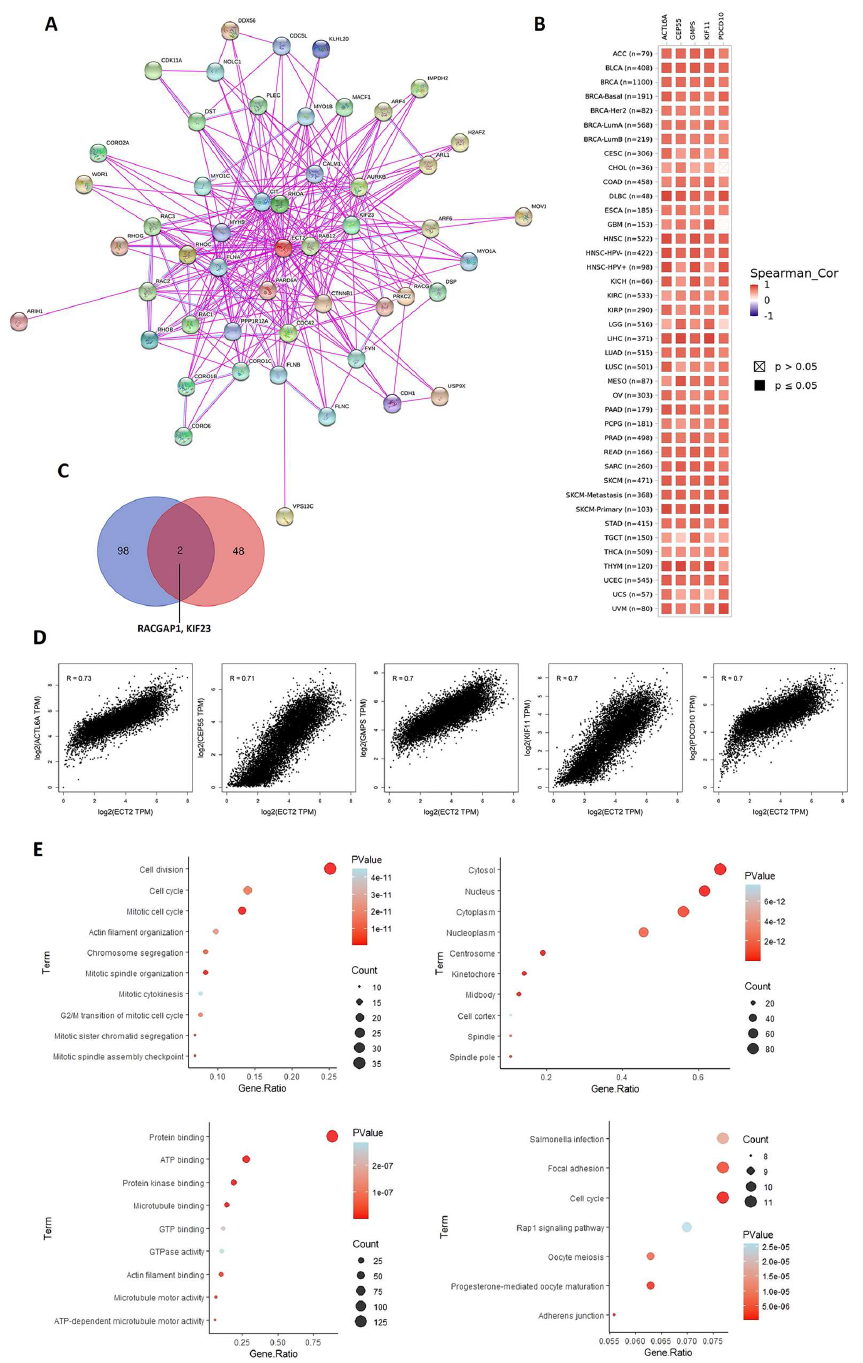
Figure 10. ECT2–protein network interactions. ( A ) A map of top 50 ECT2 interacting proteins as determined by the STRING database. ( B ) Heatmap for top 5 ECT2-correlated proteins in the tumor tissue. ( C ) Venn diagram showing the intersection between ECT2 interacting and correlating